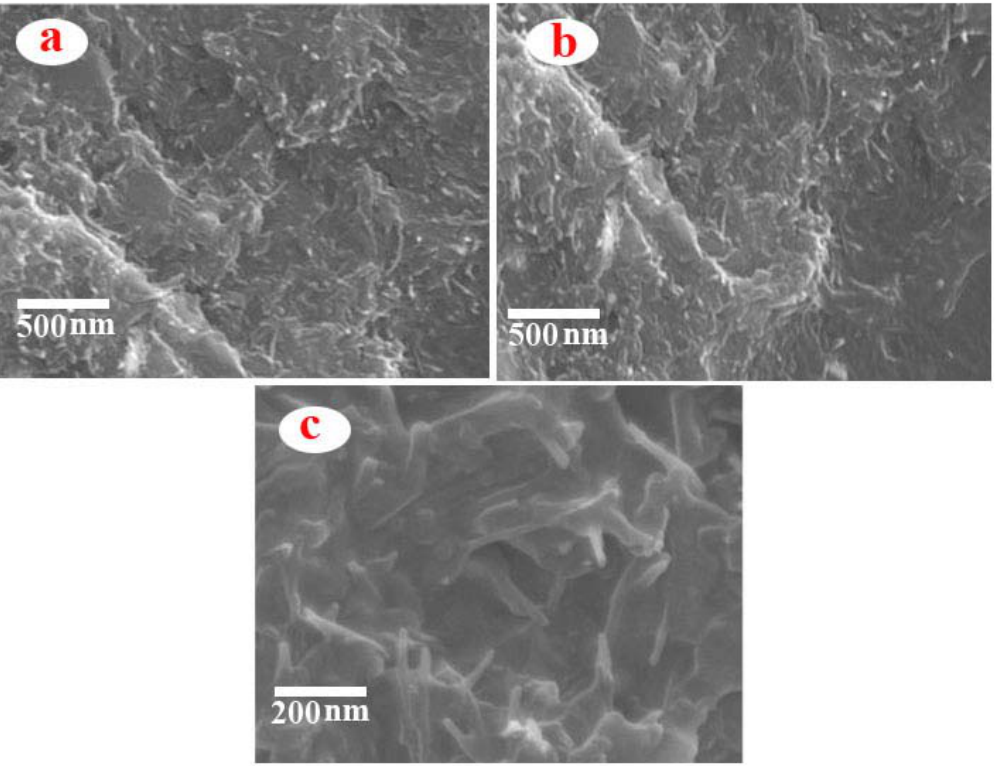
Fig. 6. FE-SEM (a-c) micrograph SPBI/clay